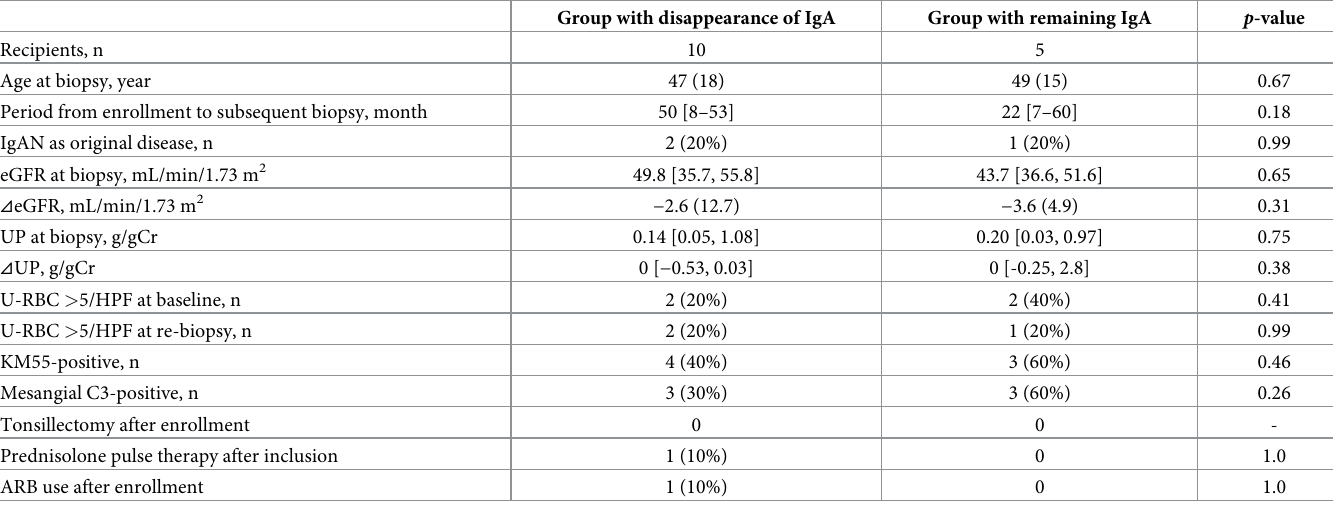
Table 4. Characteristics of recipients in the group in which IgA deposits disappeared and in the group in which they remained. Group with disappearance of IgA Group with remaining IgA p -value 10 5 47 (18)